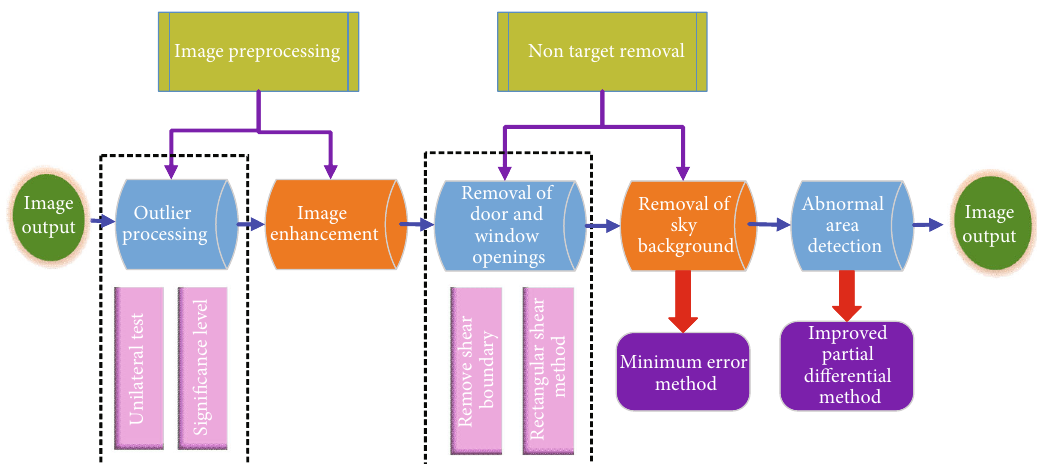
Figure 2: Image defect target recognition algorithm with